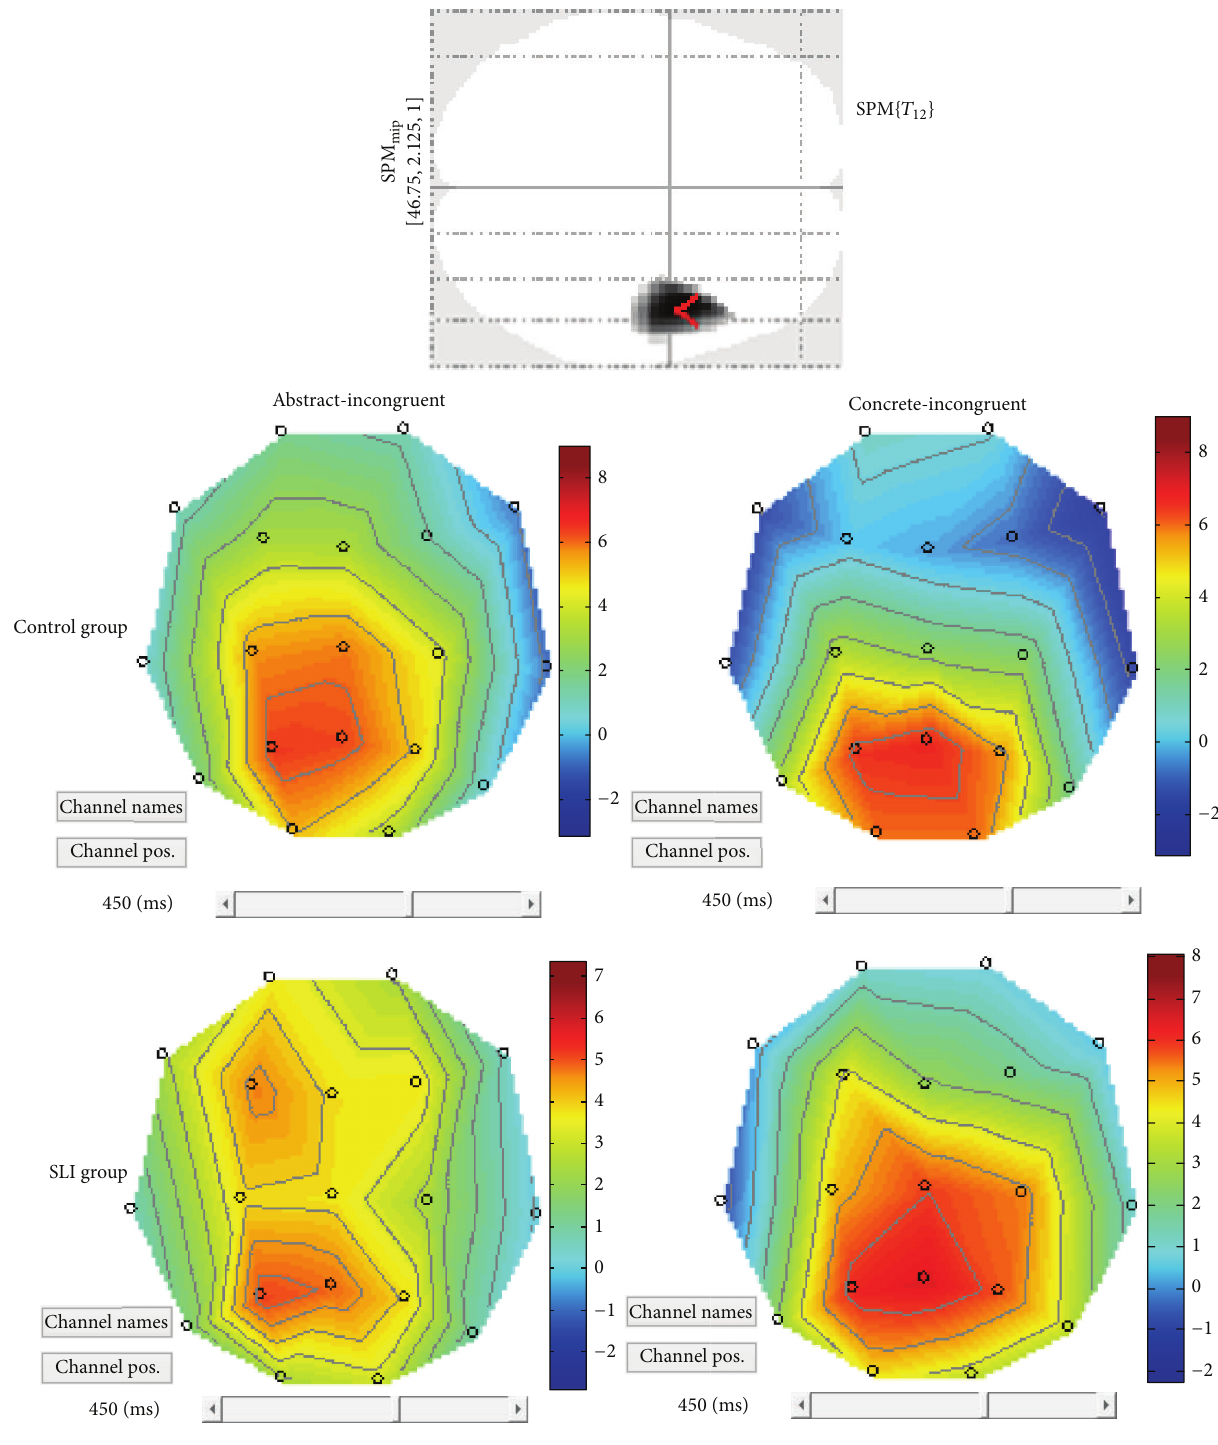
Figure 7: Patterns of brain activation in response to abstract- versus concrete-incongruent stimuli, in the control group and in the SLI group.